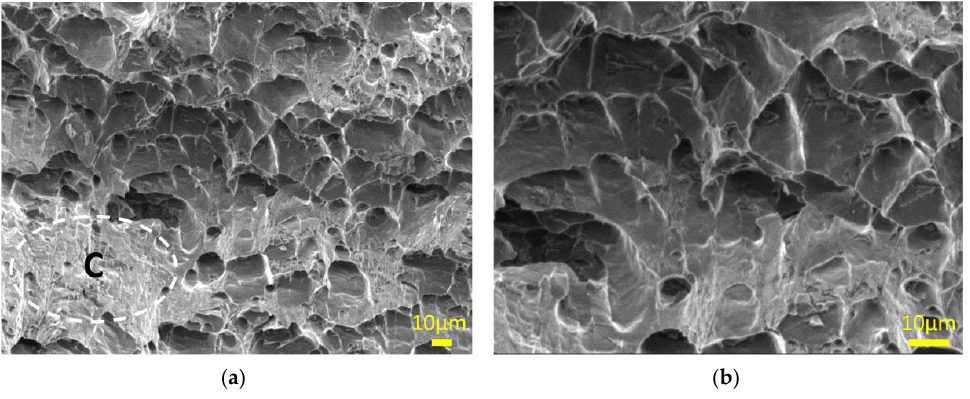
Figure 17. SEM image from RS-LHZ location: ( a ) 500 × ; and ( b ) 1000 ×